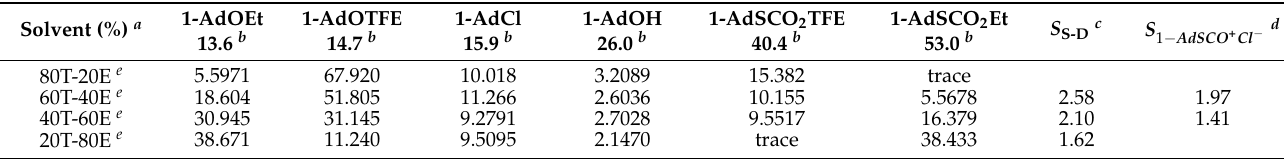
Table 4. Percentages of products formed in the solvolysis of 1 in 2,2,2-trifluoroethanol (TFE)-ethanol at 25.0 ◦ C and the calculated selectivity ( S ) values.